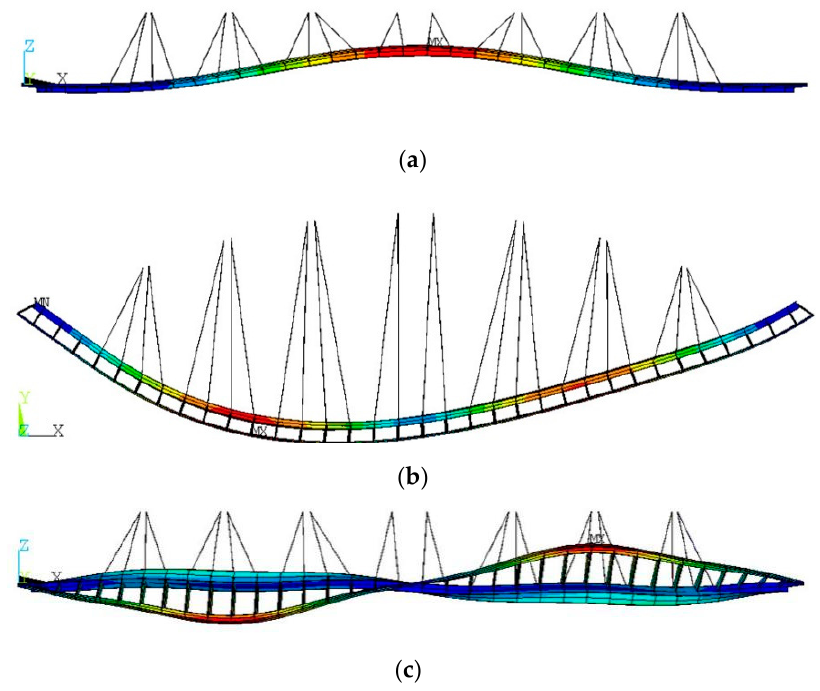
Figure 8. Vibration modal shape diagram. ( a ) First-order vertical modal (1.318 Hz), ( b ) First-order transverse bending modal (1.339 Hz), ( c ) First-order torsional modal (10.875 Hz).